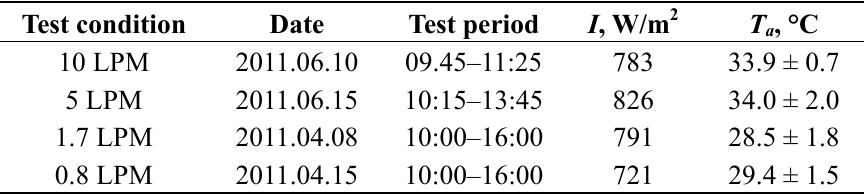
Table 3. Climatic conditions, continuous load